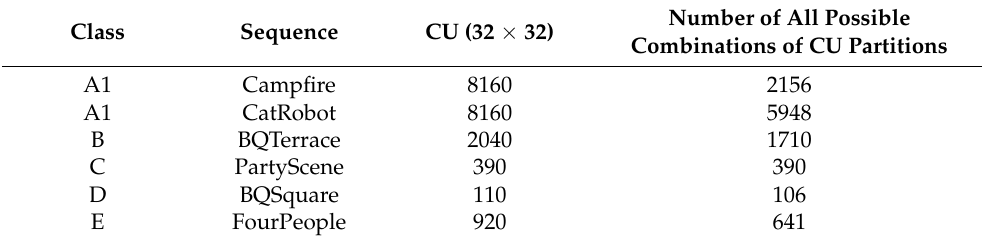
Table 1. Number of all possible combinations of CU partitions in a frame for different sequences. Class